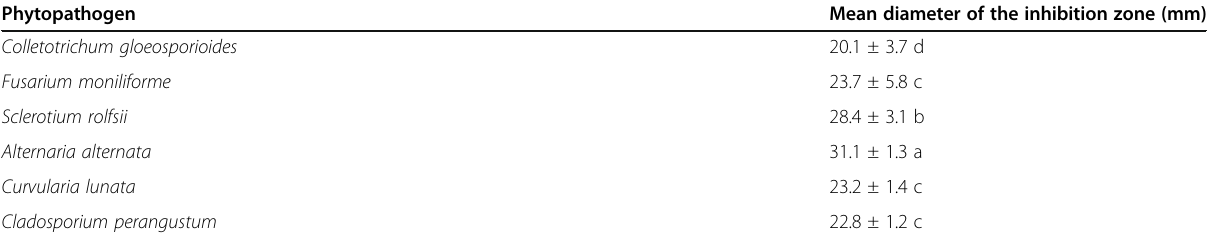
Table 1 In vitro inhibition of growth of different plant pathogens by Bacillus amyloliquefaciens on a PDA medium